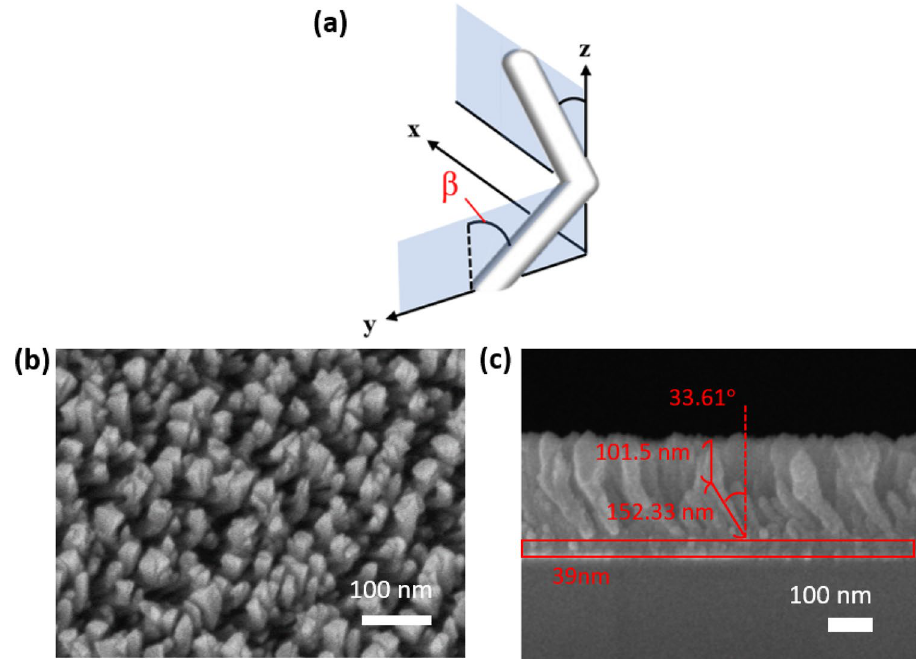
Figure 5. ( a ) Orientations of nanorods with respect to system coordinates. ( b ) Top-view and ( c ) cross-sectional SEM images of two-layered TiN